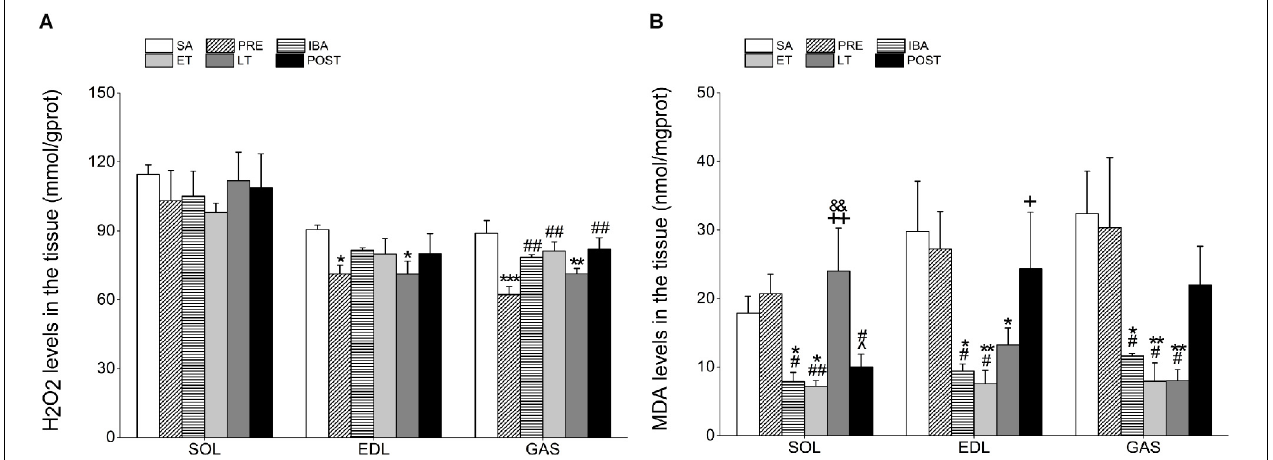
FIGURE 3 | Levels of hydrogen peroxide (H 2 O 2 ) and malondialdehyde (MDA) in different skeletal muscles. (A) Changes in H 2 O 2 levels in SOL, EDL, and GAS during different periods ( n = 8, one-way ANOVA). (B) Changes in MDA levels in SOL, EDL, and GAS during different periods ( n = 8, one-way ANOVA). SA, summer active; PRE, pre-hibernation; IBA, interbout arousal; ET, early torpor; LT, late torpor; POST, post-hibernation. Data are means ± SEM. ∗ P < 0.05, compared with SA; ∗∗ P < 0.01, compared with SA; ∗∗∗ P < 0.001, compared with SA; # P < 0.05, compared with PRE; ## P < 0.01, compared with PRE; & P < 0.05, compared with IBA; + P < 0.05, compared with ET; ++ P < 0.01, compared with ET.